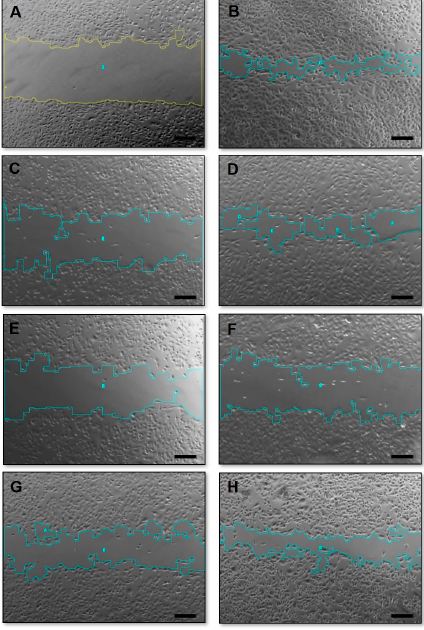
Figure 7. Phase-contrast photomicrographs of the “zero wound” ( A ) and wounds of MDA-MB-231 cell line on control group ( B ); exposed for 24 h to 70 nM of PTX ( C ); DXR ( D ); PTX:DXR combinations at 10:1 ( E ); 1:1 ( F ); or 1:10 ( G ) molar ratios and to 6.4 nM of PTX ( H ). Amplification 5×, scale bar =